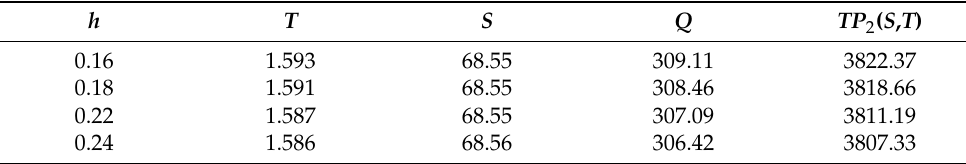
Table 6. Impact of holding cost ( h )